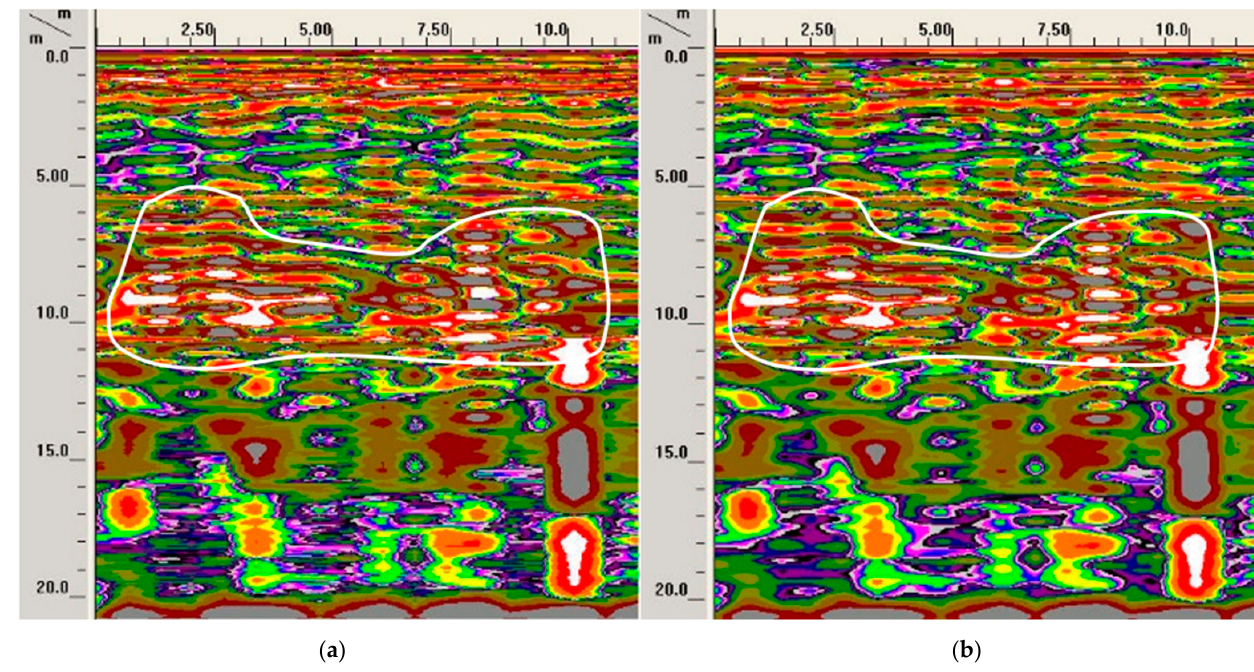
Figure 10. Comparison of images before and after wavelet transform processing of radar signals (Center frequency: 100 MHz, ( a ) is the preprocessing image, ( b ) is the processed image).